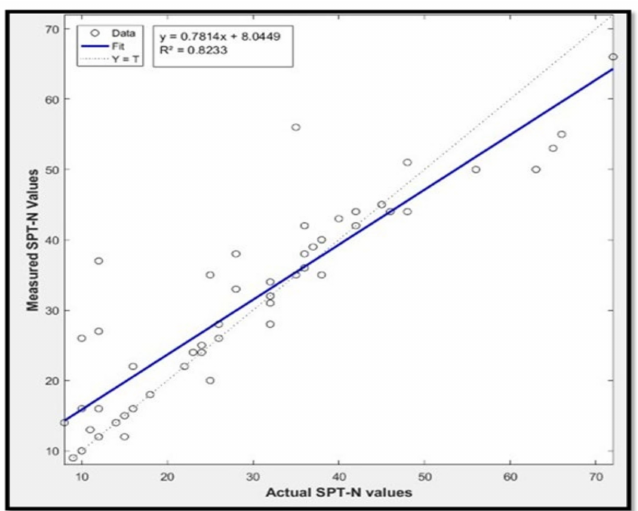
Figure 5. Validation of generated soil